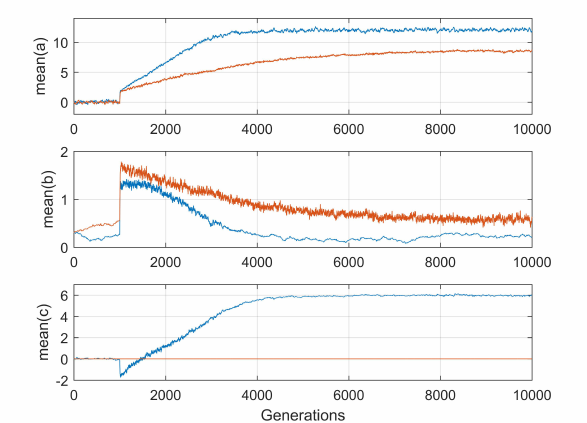
Figure 3: Step responses for the system (14,15,16), with changes in the mean environmental cue µ U from 0 to 6, and in the mean µ Θ of the phenotypic value θ that maximizes fitness from 0 to 12, at t = 1000 (blue). The ex- citation signals u − µ U and θ − µ Θ on top of the mean values µ U and µ Θ were white, = 1 . 6, while = 0 . 4 and σ 2 with variances σ 2 Θ U cov ( U, Θ) = 0 . 2. The population size was N = 1000, and the width of the fitness func- tion was ω 2 = 10. The variance of the white and zero mean non-additive component was = 0 . 5, and the trait covariances were σ 2 e G aa = 0 . 5, G bb = 0 . 045 and G cc = 0 . 5. Re- sults with G cc = 0, as in Lande (2009), are included (magenta). Note that the expected equilibrium mean slope value with G cc = 0 (cid:2) ¯ (cid:3) is E b = 0 . 5, while it with G cc = 0 . 5 is (cid:2) ¯ (cid:3) E b ≈ 0 . 22 (Ergon and Ergon,